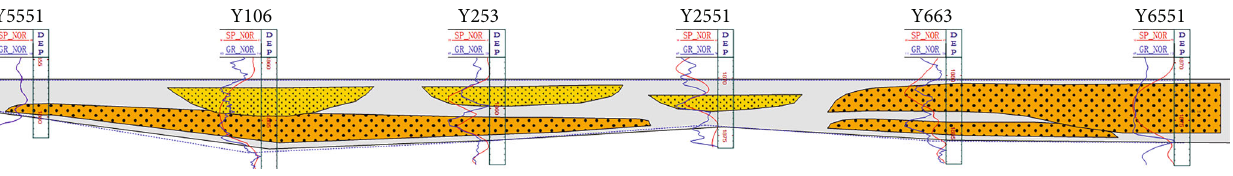
Figure 12: Pro fi le of cutting provenance direction of the single sand body of lobe complex No. 2 in member VII-15.